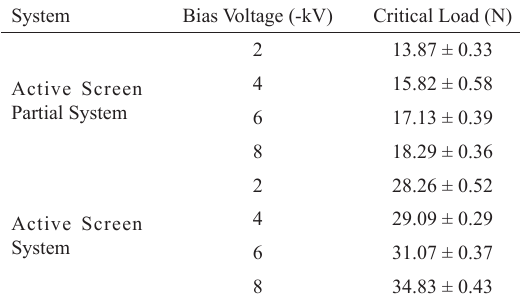
is possible to observe that tensile crack was followed by chipping and coating spallation, as expected for hard coatings over hard